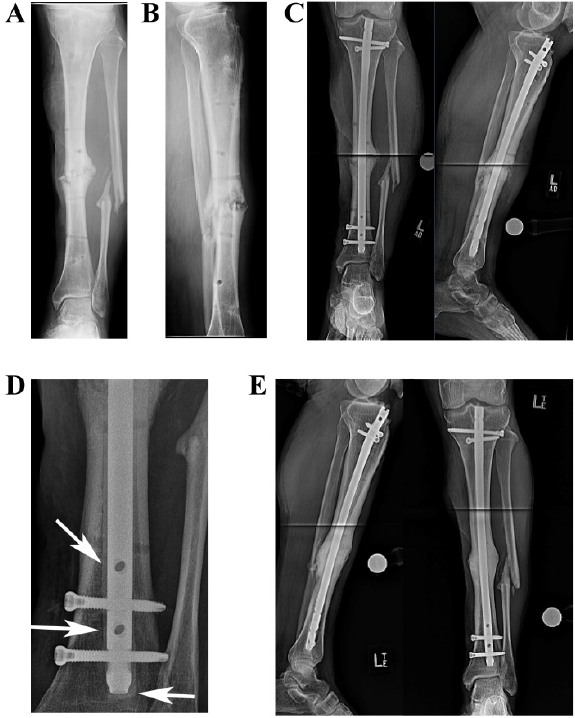
Figure 2. Serial radiographs showing a septic tibial nonunion patient who failed debridement, antibiotics, and external fixation treatment. (A) Preoperative